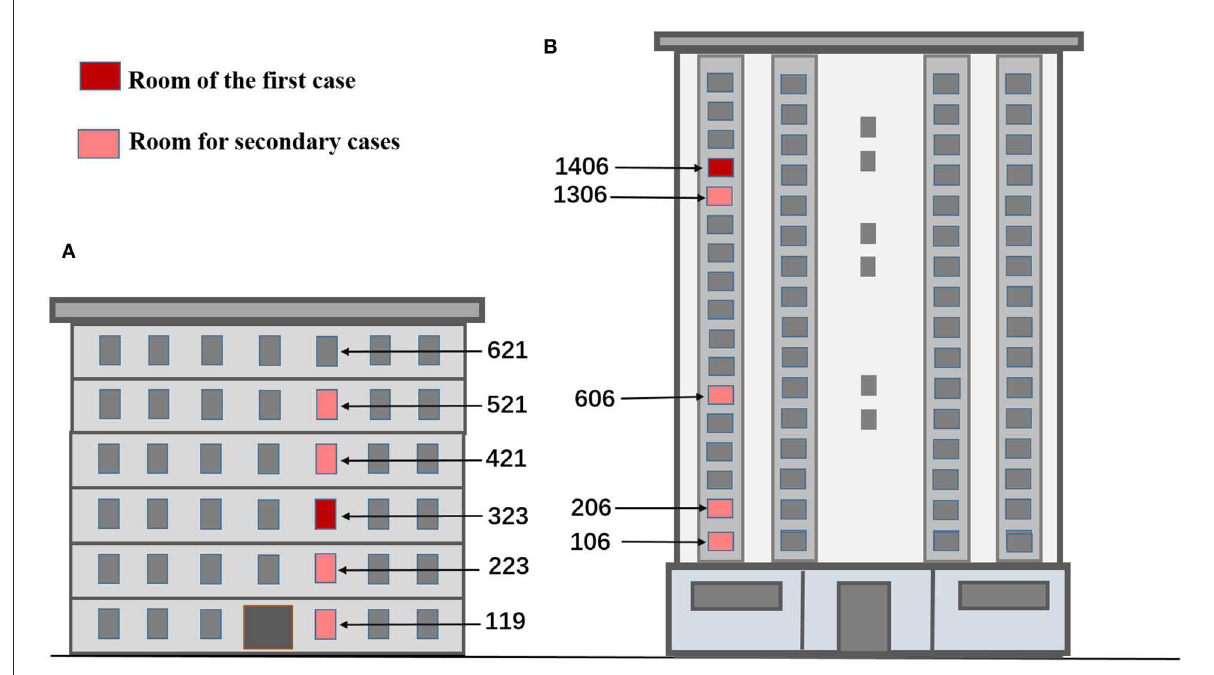
FIGURE1 Location map of rooms for simulation experiments based on infection time in buildings (A, B) . (A) The multistory apartment. (B) The high-rise residential